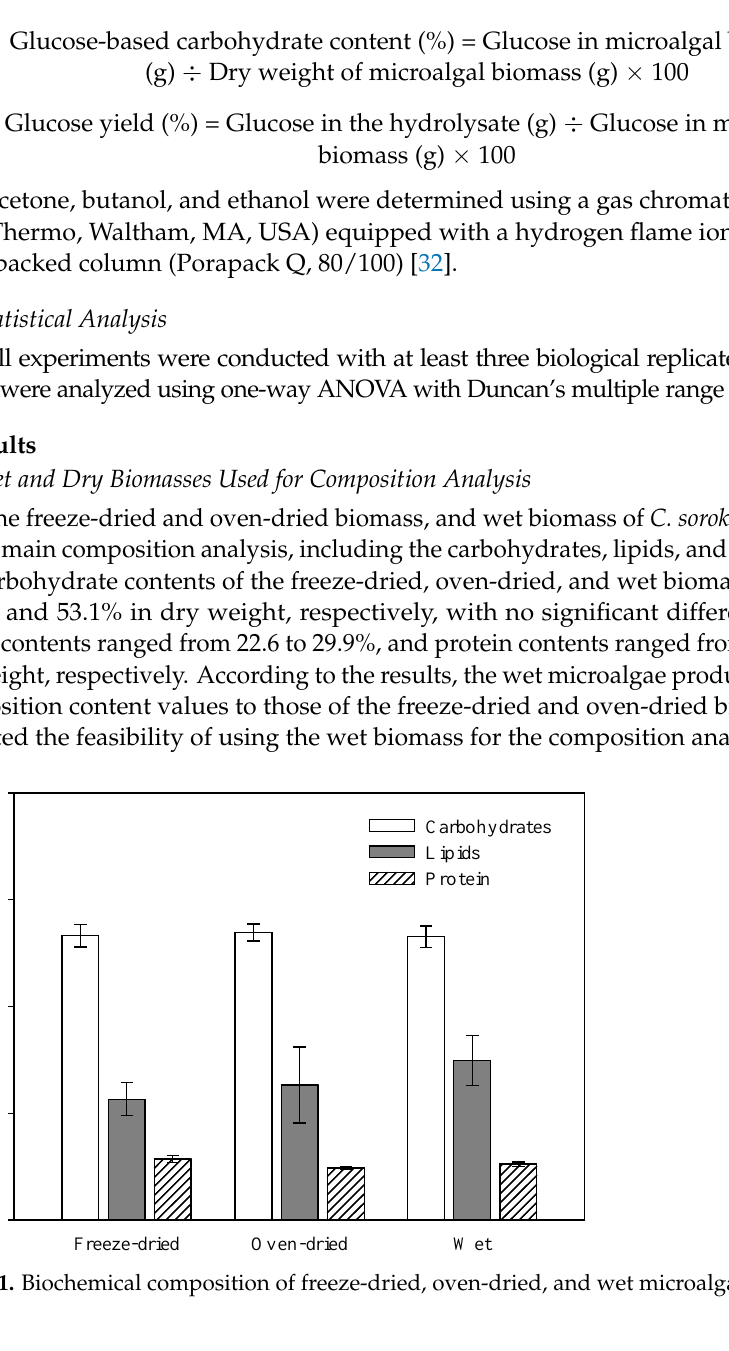
Figure 1. Biochemical composition of freeze-dried, oven-dried, and wet microalgal